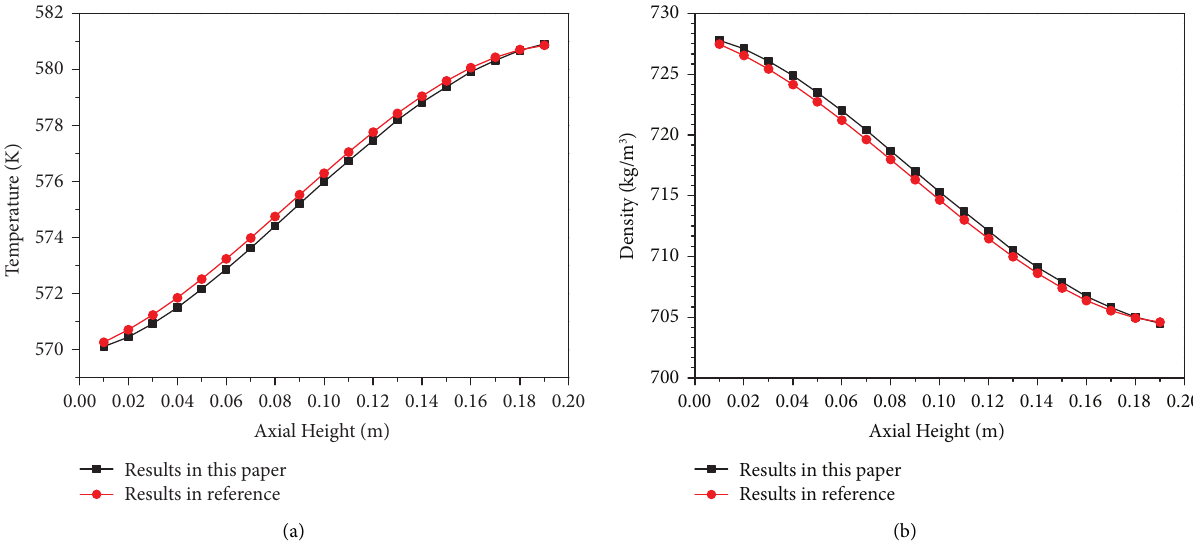
Figure 10: Comparison of the axial distribution of average coolant (a) temperature and (b) density.